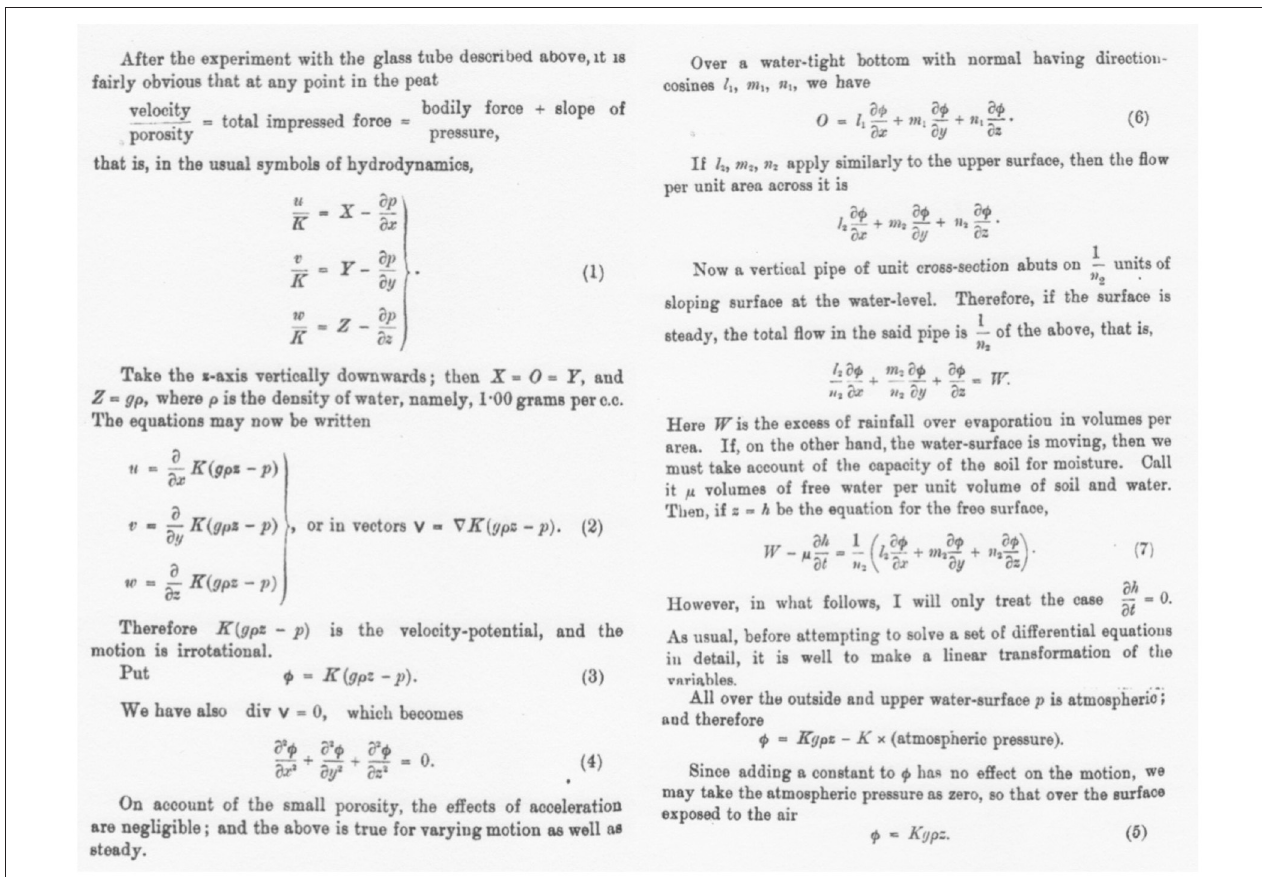
FIGURE 3 | Differential equations (Left column) and boundary conditions (Right column) for flow of water in saturated soil, copied from Richardson (1908b), with permission from the Royal Dublin Society (RDS).